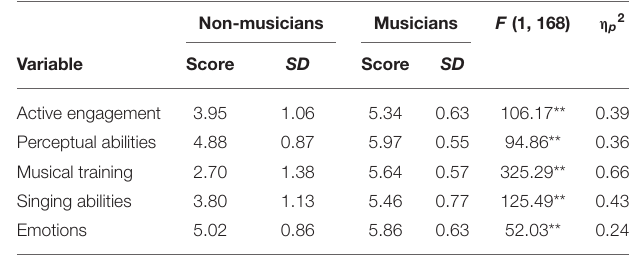
TABLE 2 | MANOVA results for non-musicians ( N = 86) and musicians ( N = 84).